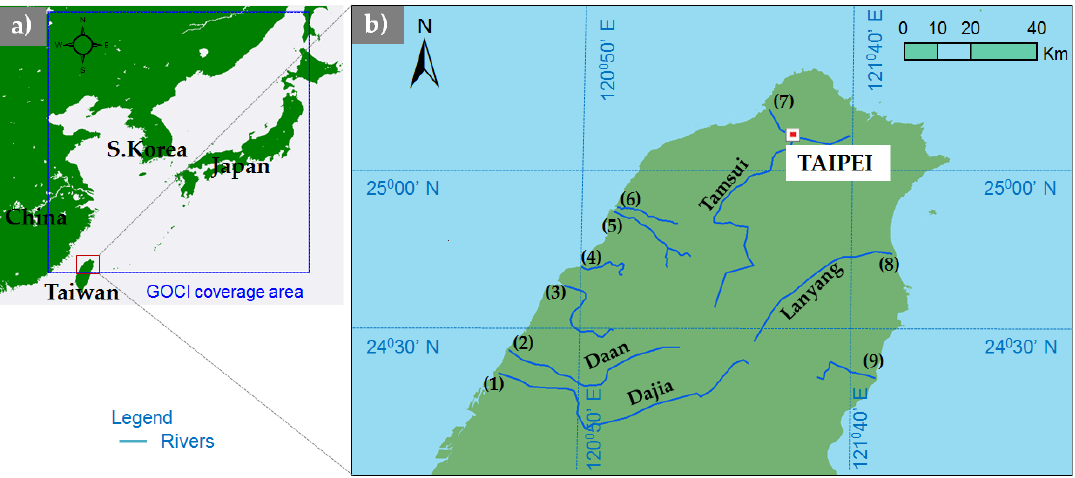
Figure 1. ( a ) Visualization of Geostationary Ocean Color Imager (GOCI) coverage area; ( b ) study area.